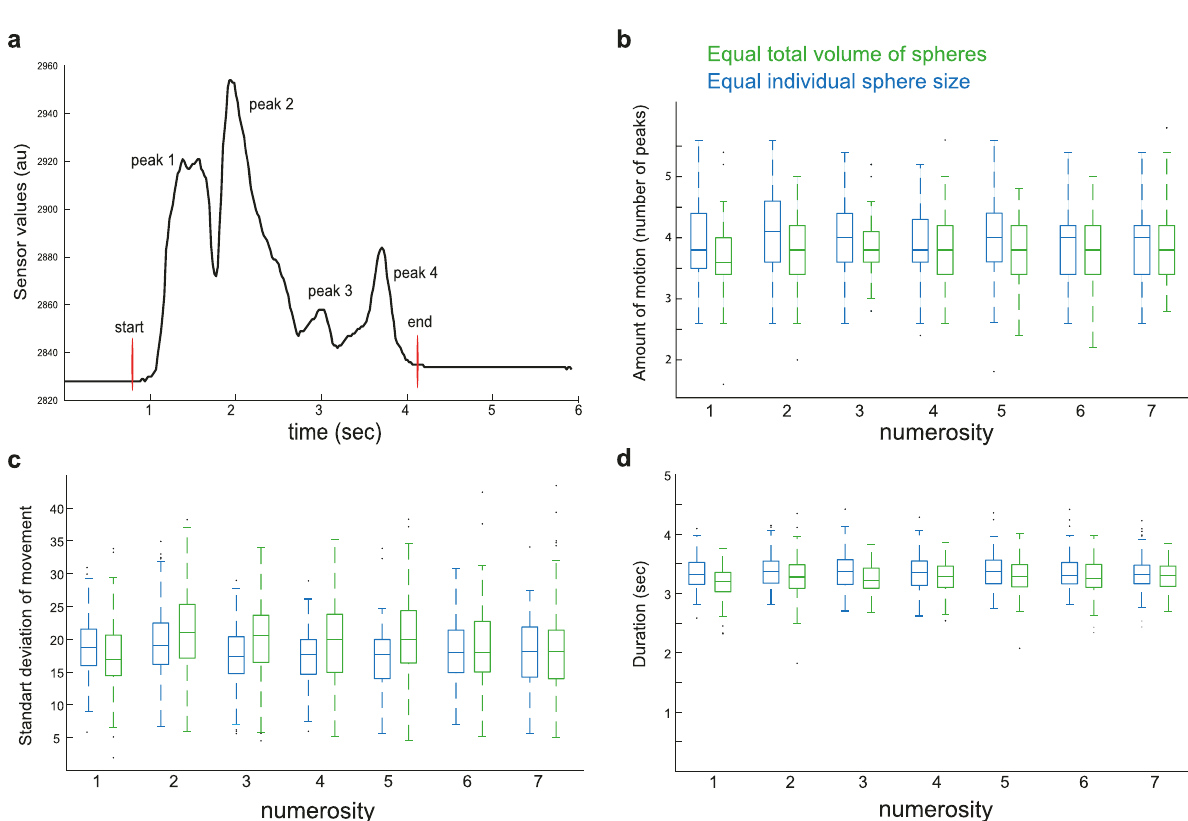
Fig. 4 Motor properties of the exploration task did not vary with haptic numerosity. a Hand motion during haptic exploration of spheres was recorded using a glove that captures fi ngers motion. The epochs of spheres exploration were extracted for each fi nger. For each epoch, we measured b the number of unique motions as indicated by the number of peaks in the sensor values c the total amount of motion as indicated by the standard deviation of sensor values, and d the duration of motion as indicated by the start and end of the changes in sensor values irrespective of the beginning and end positions. Box plot diagrams present these parameters averaged across fi ngers and grouped across haptic epochs of all participants ( n = 100). We did not fi nd any difference in these parameters as numerosity increased, in either of the two haptic stimuli conditions of equal total volume or equal individual sphere size. Indeed, Bayesian statistics provided evidence that there are no differences in these parameters as a function of numerosity. In the box-plot diagram, the central mark indicates the median, and the bottom and top edges of the box indicate the 25th and 75th percentiles, respectively. The whiskers extend to the most extreme data points not considered outliers, and the outliers are plotted individually using the dot placed at the hand) should be comparable to the original task motion. The amount of motion was calculated by the number of performed in the scanner, allowing us to evaluate whether fi ngers distinct movements as indicated by the number of peaks, the total motion changes with numerosity. variation of motion was the standard deviation (STD) of the We quanti fi ed the amount of fi nger motion in each sphere signal, and the duration of motion as indicated by the start and exploration epoch (Fig. 4a) by three parameters: the number of end of the changes in sensor values irrespective of the beginning unique motions, total variation of motion, and duration of and end positions (Fig. 4a).